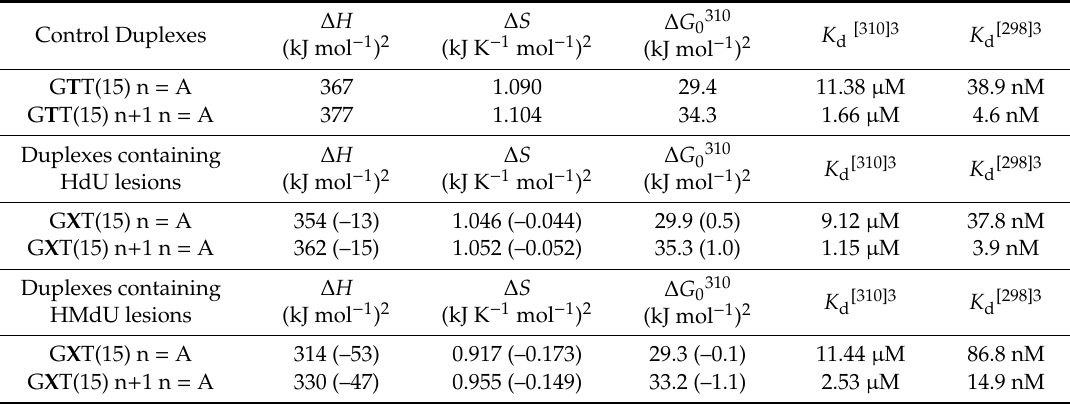
Table 1. MST-derived thermodynamic parameters for the dissociation of duplexes formed between the 15mer DNA templates G T T(15) and G X T(15) (X = HdU or HMdU) and the matched or mismatched primers n or n + 1, where n = A nucleotide. 1.